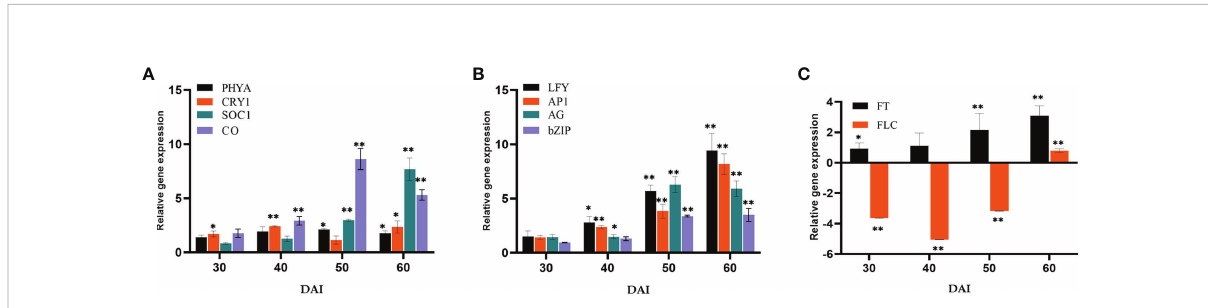
FIGURE 5 Relative gene expression of representative genes in the photoperiod pathway (A) PHYA , CRY1 , SOC1 & CO , (B) LFY , AP1 , AG & bZIP , (C) FT & FLC , responsible for fl owering response. The samples were isolated for qRT-PCR at 30, 40, 50 and 60 DAI. Error bars shows ±SEs of three biological replicates. As per student t - test, ** P< 0.01 and * P <